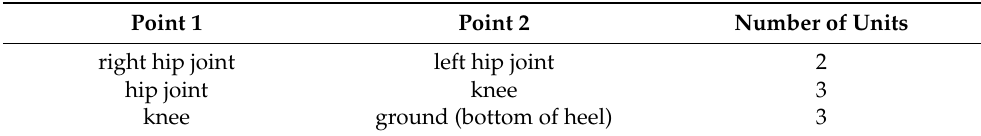
Table 1. Proportions of the human body according to the R.B. Hale model [13].